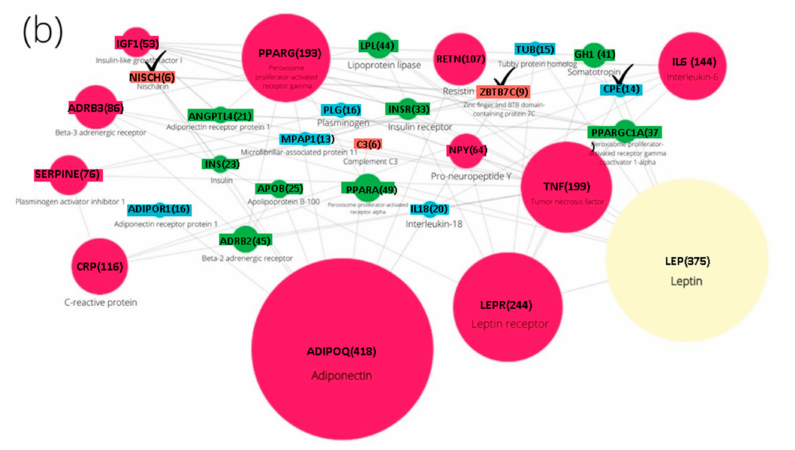
Figure 2. ( a ) Obesity at-a-glance. The compendium of PubMed abstracts from the top ten most cited authors is depicted as a network of MeSH terms. The size of the nodes reflects the occurrence of the MeSH terms in the sampled abstracts. ( b ) Gene network based on DisGeNET data obtained on the request “obesity.” The publications from DisGeNET were retrieved as a file in which the names of genes were assigned to the PubMed identifiers, and in this format were uploaded to ScanBious for visualization and interactive work with the texts of the abstracts of publications. The number of publications in which the name of the gene was found is indicated in parentheses after the gene name. The checkmarks indicate the notes of the network which are described in the